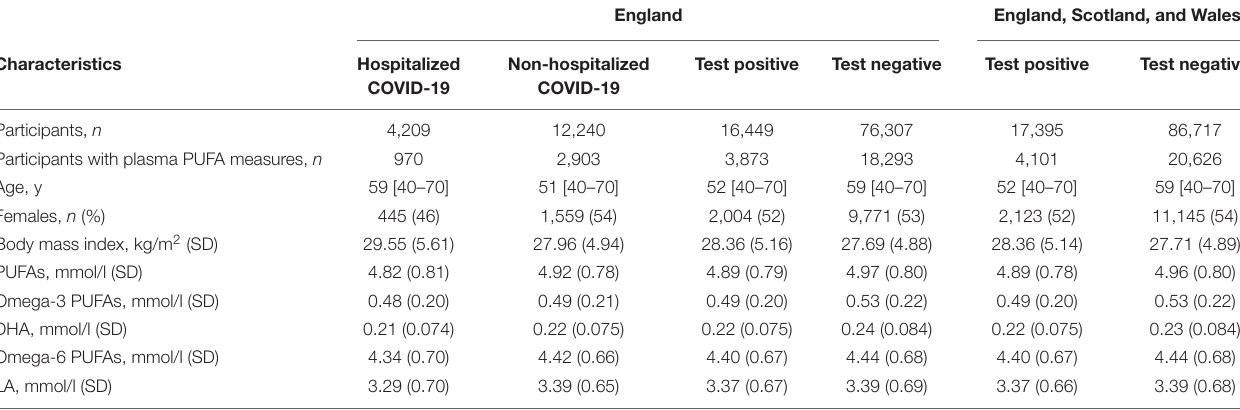
TABLE 1 | Characteristics of the UK Biobank participants at baseline.*